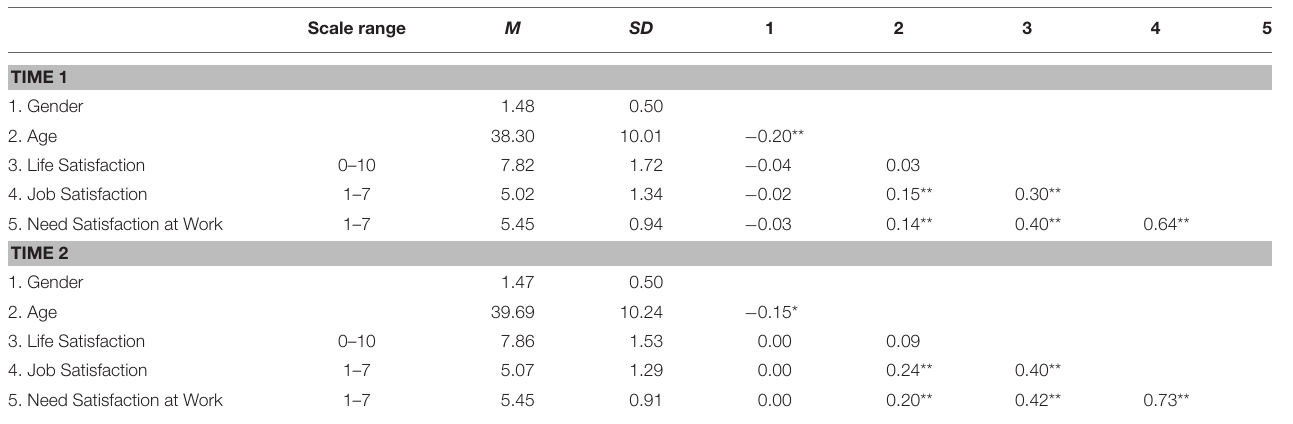
TABLE 3 | Descriptives and inter-correlations between all study 2